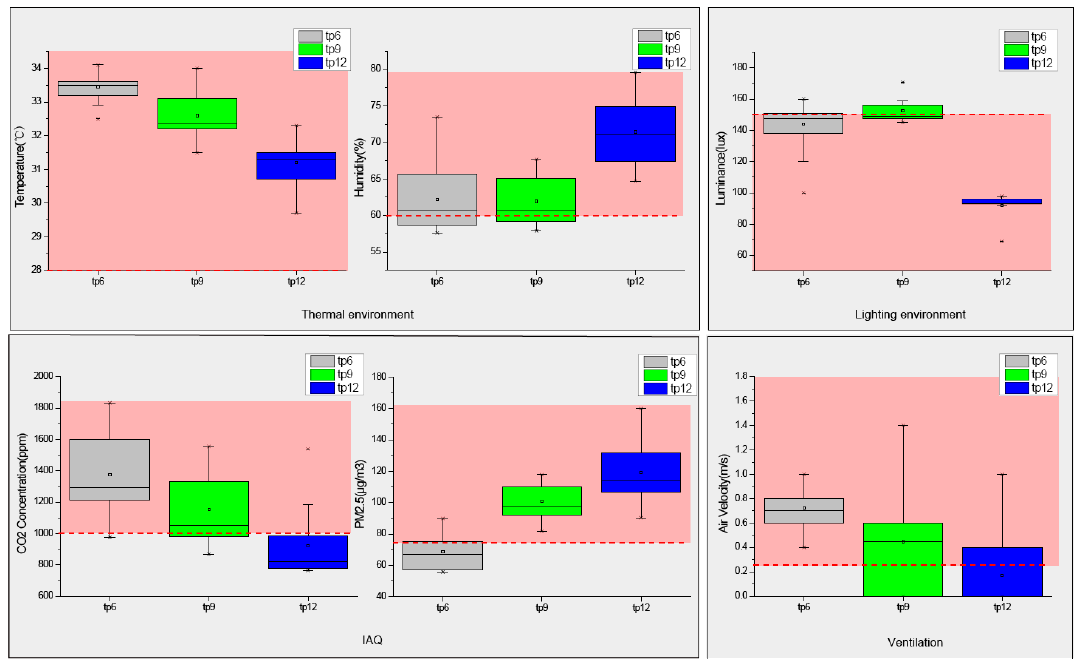
Figure 9. Box diagram of the physical test results from the station hall.